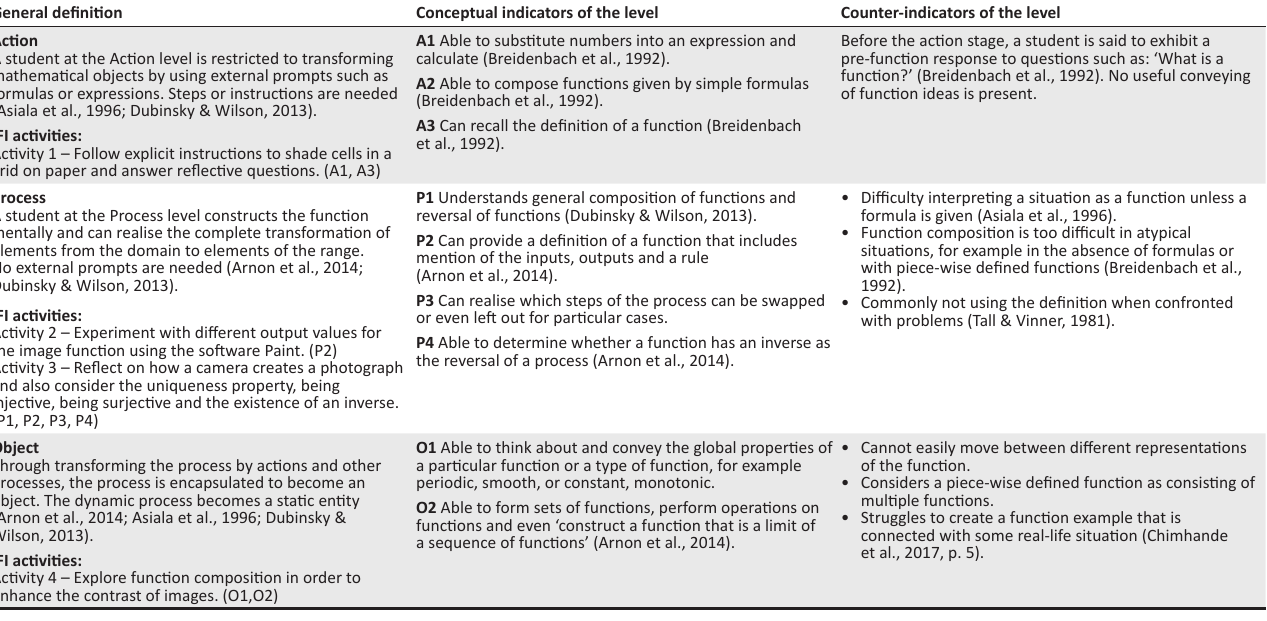
TABLE 2: Indicators and counter-indicators of APOS level attainment with respect to the function concept. General definition Conceptual indicators of the level Counter-indicators of the level